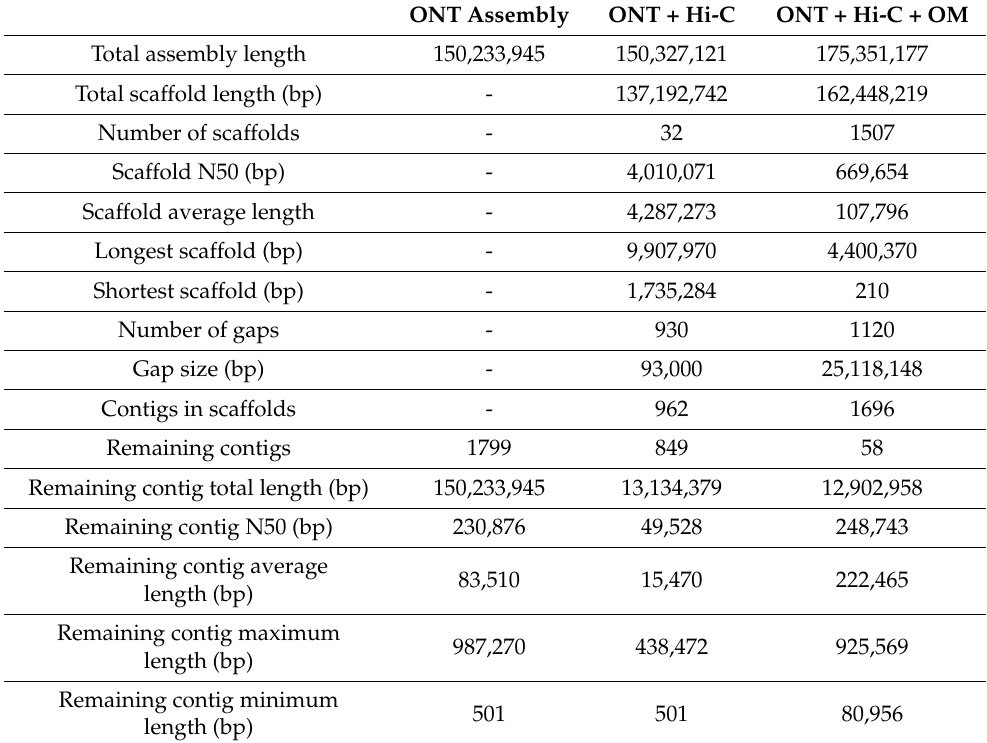
Table 1. Statistical data for the H. lacustris assembly (ONT assembly) scaffolded with Hi-C (ONT + Hi-C) and then corrected and anchored with optical maps (ONT + Hi-C + OM). ONT Assembly ONT + Hi-C ONT + Hi-C +